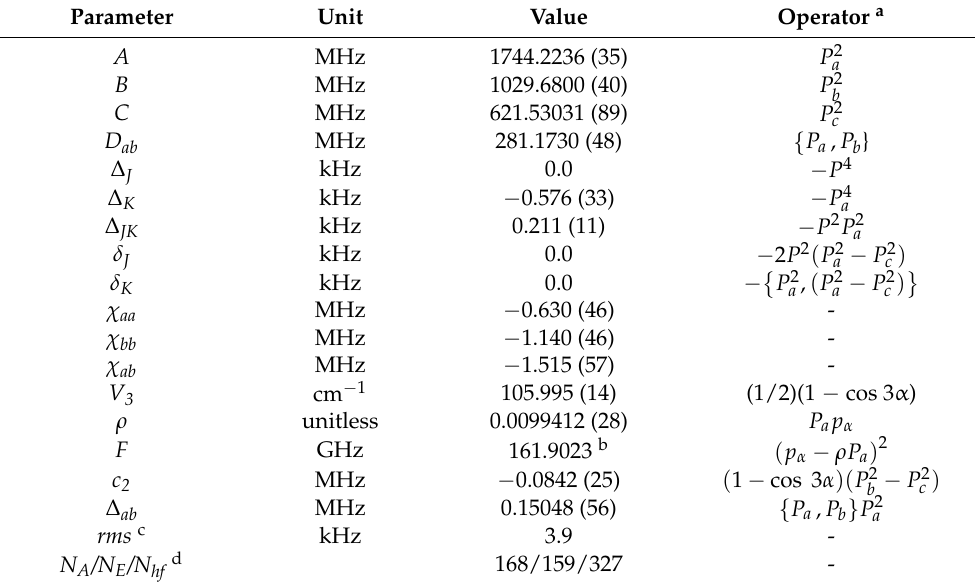
Table 3. Spectroscopic constants of 4MNP-1 in the RAM system obtained using the program BELGI- C s -hyperfine